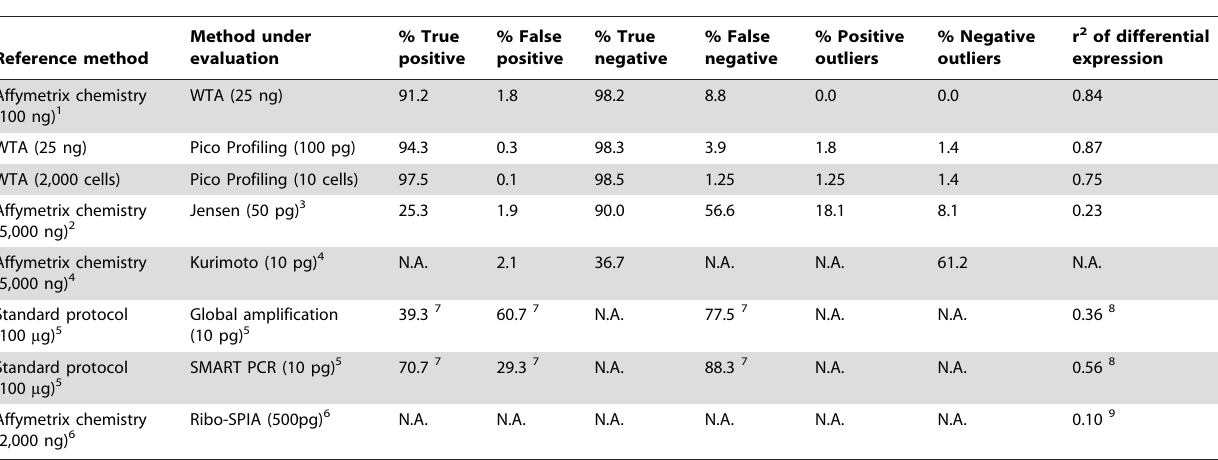
Table 1. Comparison of expression profiling results generated by standard protocols versus small amounts of RNA.